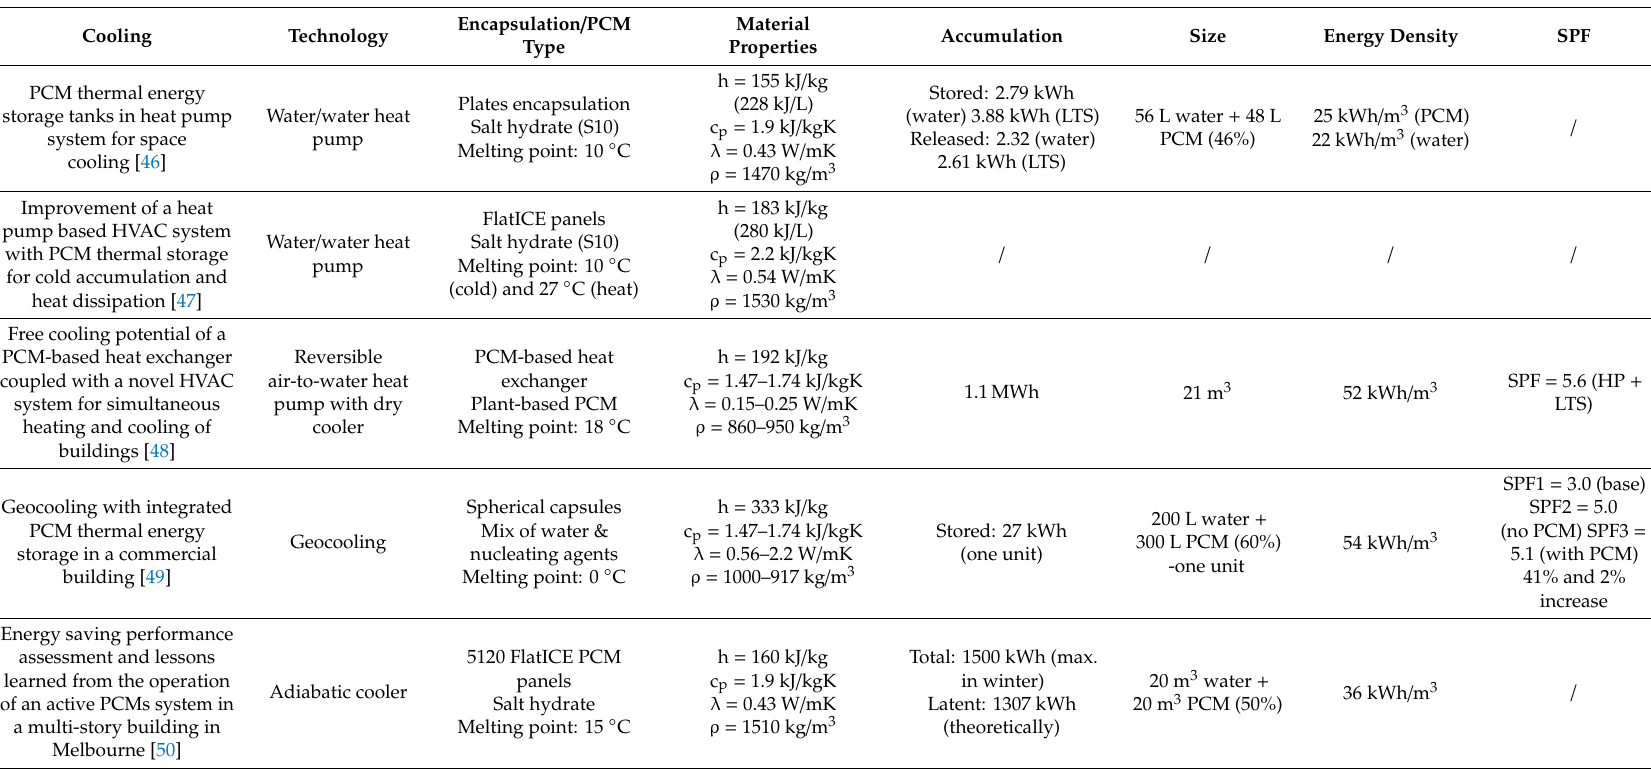
Table 1. Overview of cooling technologies with phase-change materials